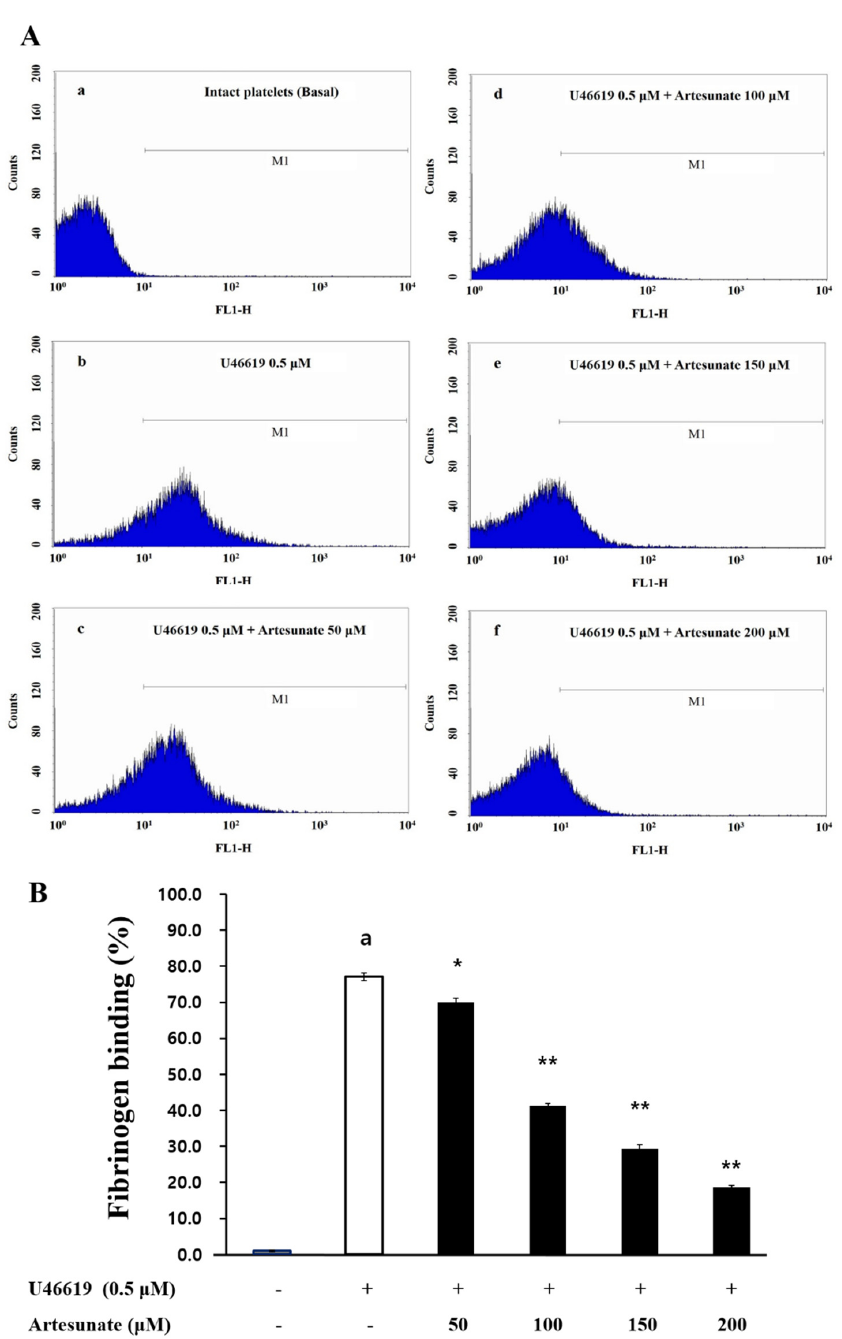
Figure 5. Artesunate’s effects on the binding of fibrinogen. ( A ) The histograms of flow cytometry on the binding of fibrinogen. ( a ) Intact platelets (base); ( b ) U46619 (0.5 µ M); ( c ) U46619 (0.5 µ M) + artesunate (50 µ M); ( d ) U46619 (0.5 µ M) + artesunate (100 µ M); ( e ) U46619 (0.5 µ M) + artesunate (200 µ M); ( f ) U46619 (0.5 µ M) + artesunate (300 µ M). ( B ) Artesunate’s effect on the binding (%) of fibrinogen induced by U46619. After treatment with Alexa Fluor 488-human fibrinogen (30 µ g/mL) by adding 2 mM CaCl 2 to the suspended platelets (10 8 cells/mL), U46619 (0.5 µ M) was used for stimulation at a duration of 5 min. After adding phosphate-buffered saline (PBS, pH 7.4) containing 0.5% paraformaldehyde, the reaction was terminated. Light blocking was used during this process and a flow cytometer (FACS) measured fibrinogen binding. The results are shown as mean ± SD ( n = 4). a p < 0.05 in comparison to non − stimulated platelets, * p < 0.05, ** p < 0.001 in comparison to the U46619 − induced platelets.